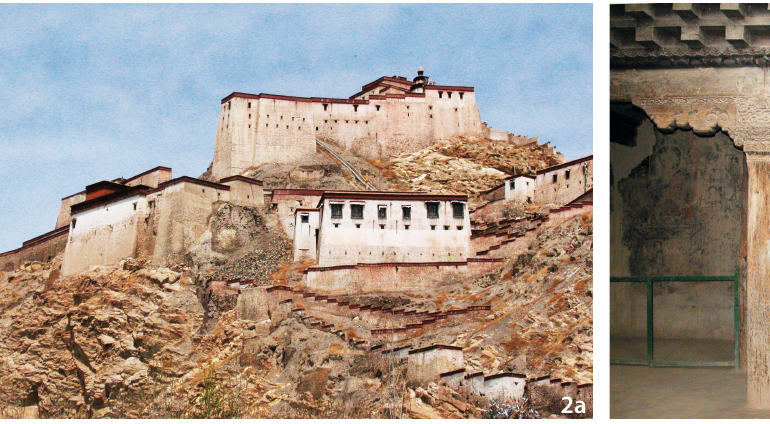
Figure 2a Skyline of dzong mountain in Gyantsé (Source: the author). Figure 2b the interior of the dzong palace (Source: the author). Figure 3 The relics of the dzong palace in Gonggar (Source: http://blog.